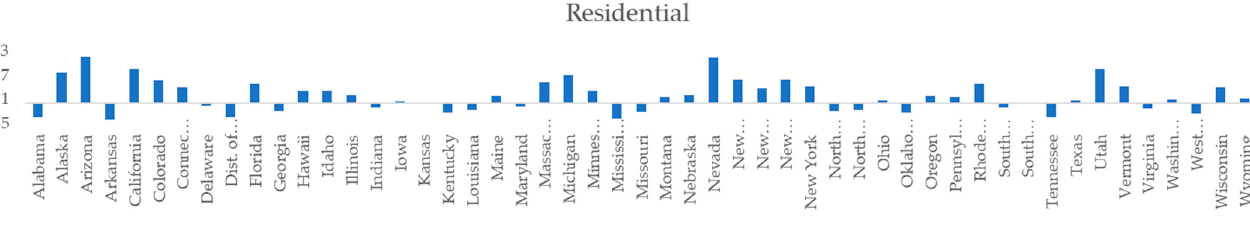
Figure 9. Change in 2020 sector energy consumption by state [30].